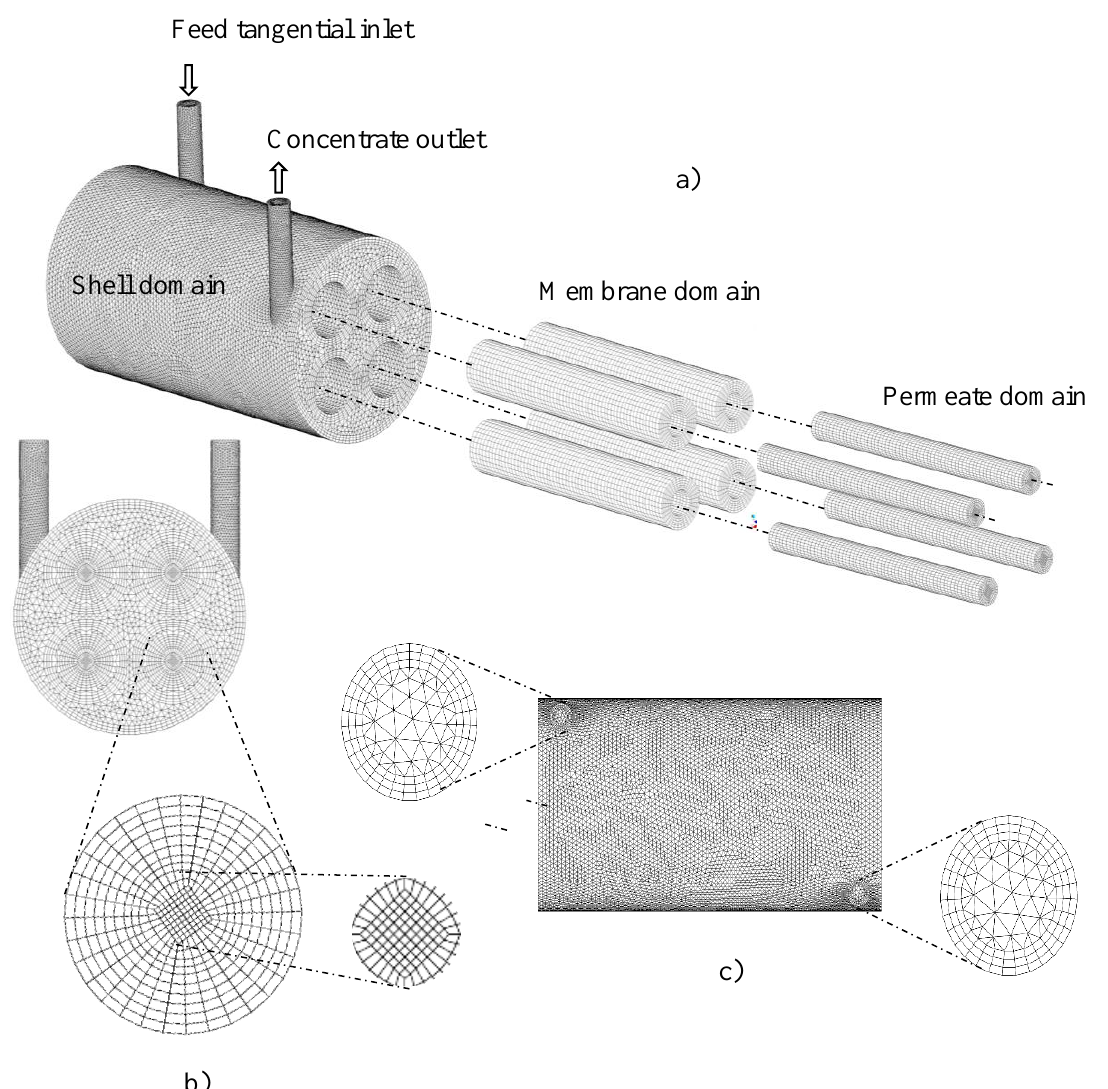
Figure 2. The numerical mesh of the module under study, ( a ) Detail of the membranes, ( b ) Details at the exit of the membrane, and ( c ) Details of the inlet and outlet of the permeation module.